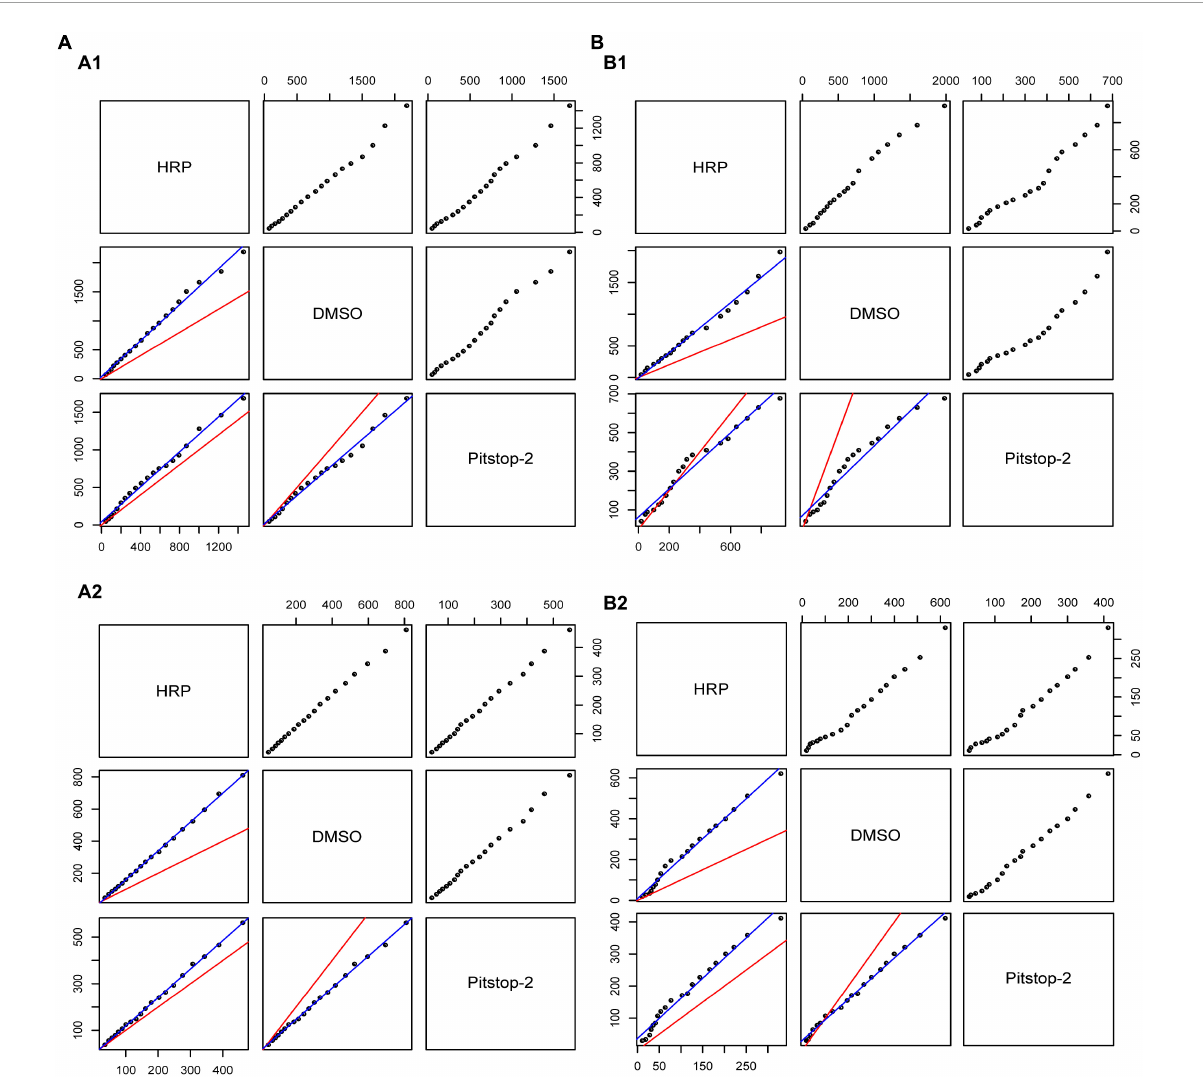
FIGURE5 The distances between endocytic compartments and the PM at the innervation side or backside are insensitive to Pitstop-2 treatment. (A,B) Quantile-Quantile plots for probability distributions of mean distances from bSVs (A) and large endosomes (B) to the PM at the innervation side (A1,B1) and to the PM at the back of the synapse (A2,B2) in comparison between control and treatment groups. The red line represents the case of identical distributions, whereas the blue line represents similar, statistically not significantly different distributions (see Materials and methods) ( n = 3–4 calyces/group, 1